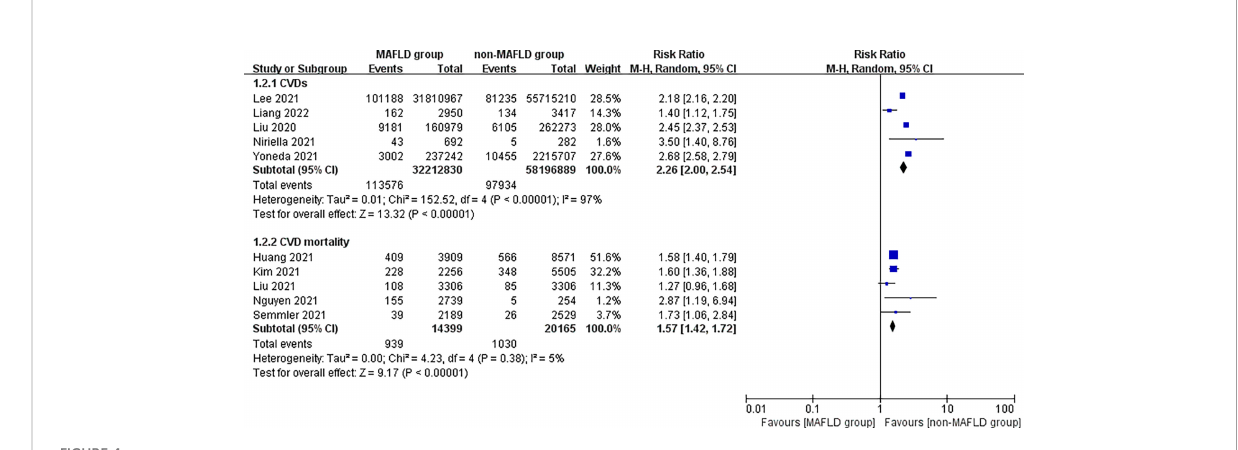
FIGURE 4 Overall relative risk of CVD incidence and CVD mortality during follow-up between the MAFLD-only and NAFLD-only groups.